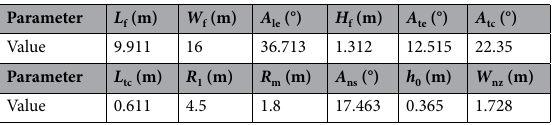
Table 1. The main size distribution of the aircraft model.